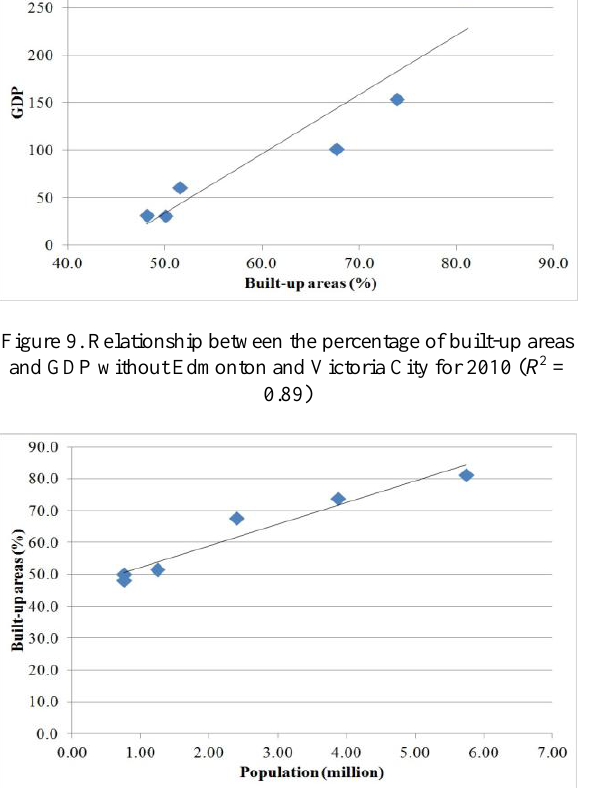
Figure 10. Relationship between the percentage of built-up areas and population without Edmonton and Victoria City for 2010 ( R 2 =